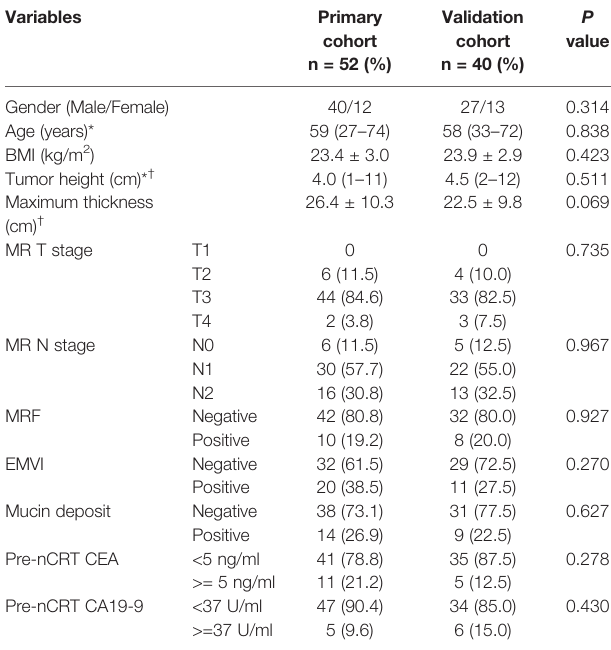
TABLE 1 | Demographic and clinical characteristics of the study